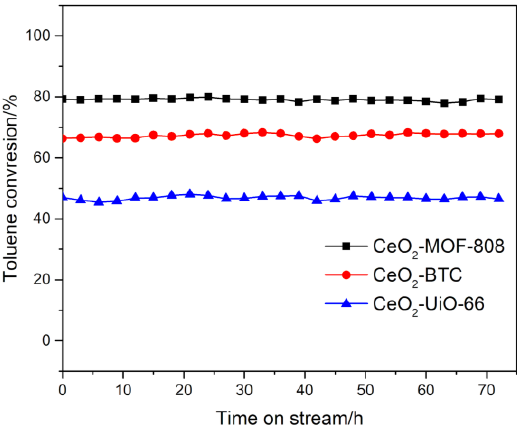
Figure 9. The stability test of the three ceria samples. Reaction conditions: toluene concentration: 1000 ppm; gas hourly space velocity (GHSV): 60,000 mL/(g·h); temperature: 260 °C.